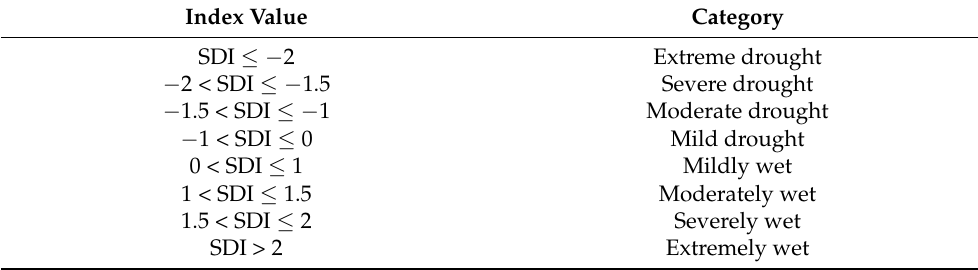
Table 2. Drought classification